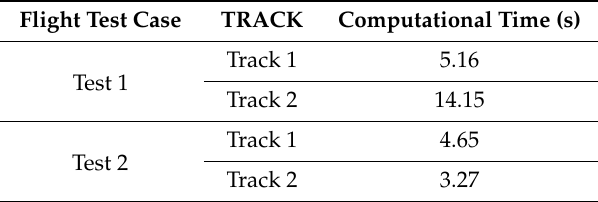
Table 8. Computational